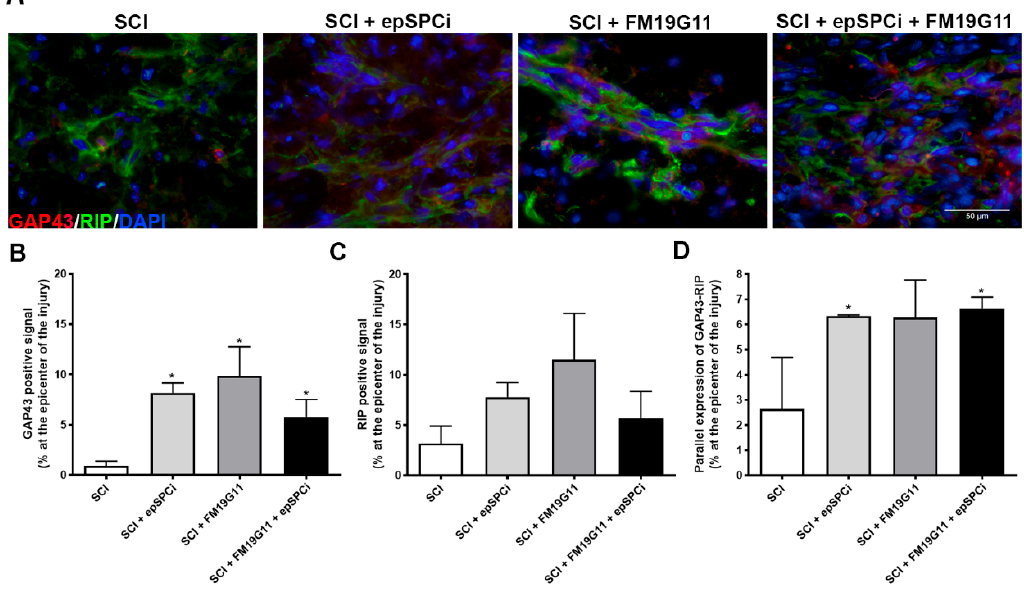
Figure 4. Treatment with FM19G11 plus epSPCi preserves larger numbers of neuronal fibers. ( A ) Representative immunofluorescence images at high magnification of receptor interacting protein (RIP, green ) and GAP43 ( red ) expression at the epicenter of the injury are shown for every experimental condition (scale bar, 50 µm); ( B ) quantification of the GAP43 (growth cone marker); ( C ) RIP (mature oligodendrocyte marker) or ( D ) the parallel detection of the GAP43 and RIP-positive signal at the epicenter of the injury expressed as a percentage of the total epicenter area, equivalent in length for all tested groups. Quantitative data are expressed as the mean ± S.E.M. (ANOVA), * p < 0.05 in comparison with SCI (control).